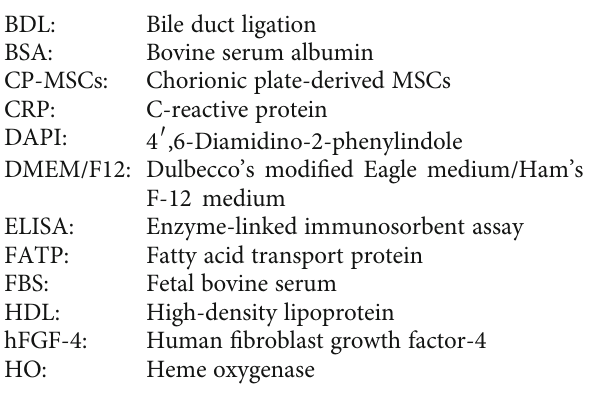
Supplementary Figure 1: engraftment and tracing of PHK67 fl uorescence-labeled human PD-MSC in BDL-injured rat livers. The engrafted PD-MSCs into the rat liver were detected and traced by labeling the PKH67 (green) using fl uorescence microscope (a) and (c). n = 5 per group, scale bars: 20 μ m. Th expression of human-speci fi c Alu sequence in BDL-injured rat livers after PD-MSC transplantation using quantitative real-time PCR analysis (b). n = 3 per group. ∗ NTX group vs. p < 0 : 05 . Data were represented as the mean ± SD . Supplementary Figure 2: the representative images of immuno fl uorescence were stained with WB-F344s for β -catenin and BrdU in normal and LCA-treated group. LCA: lithocholic acid-treated group. Scale bars: 50 μ